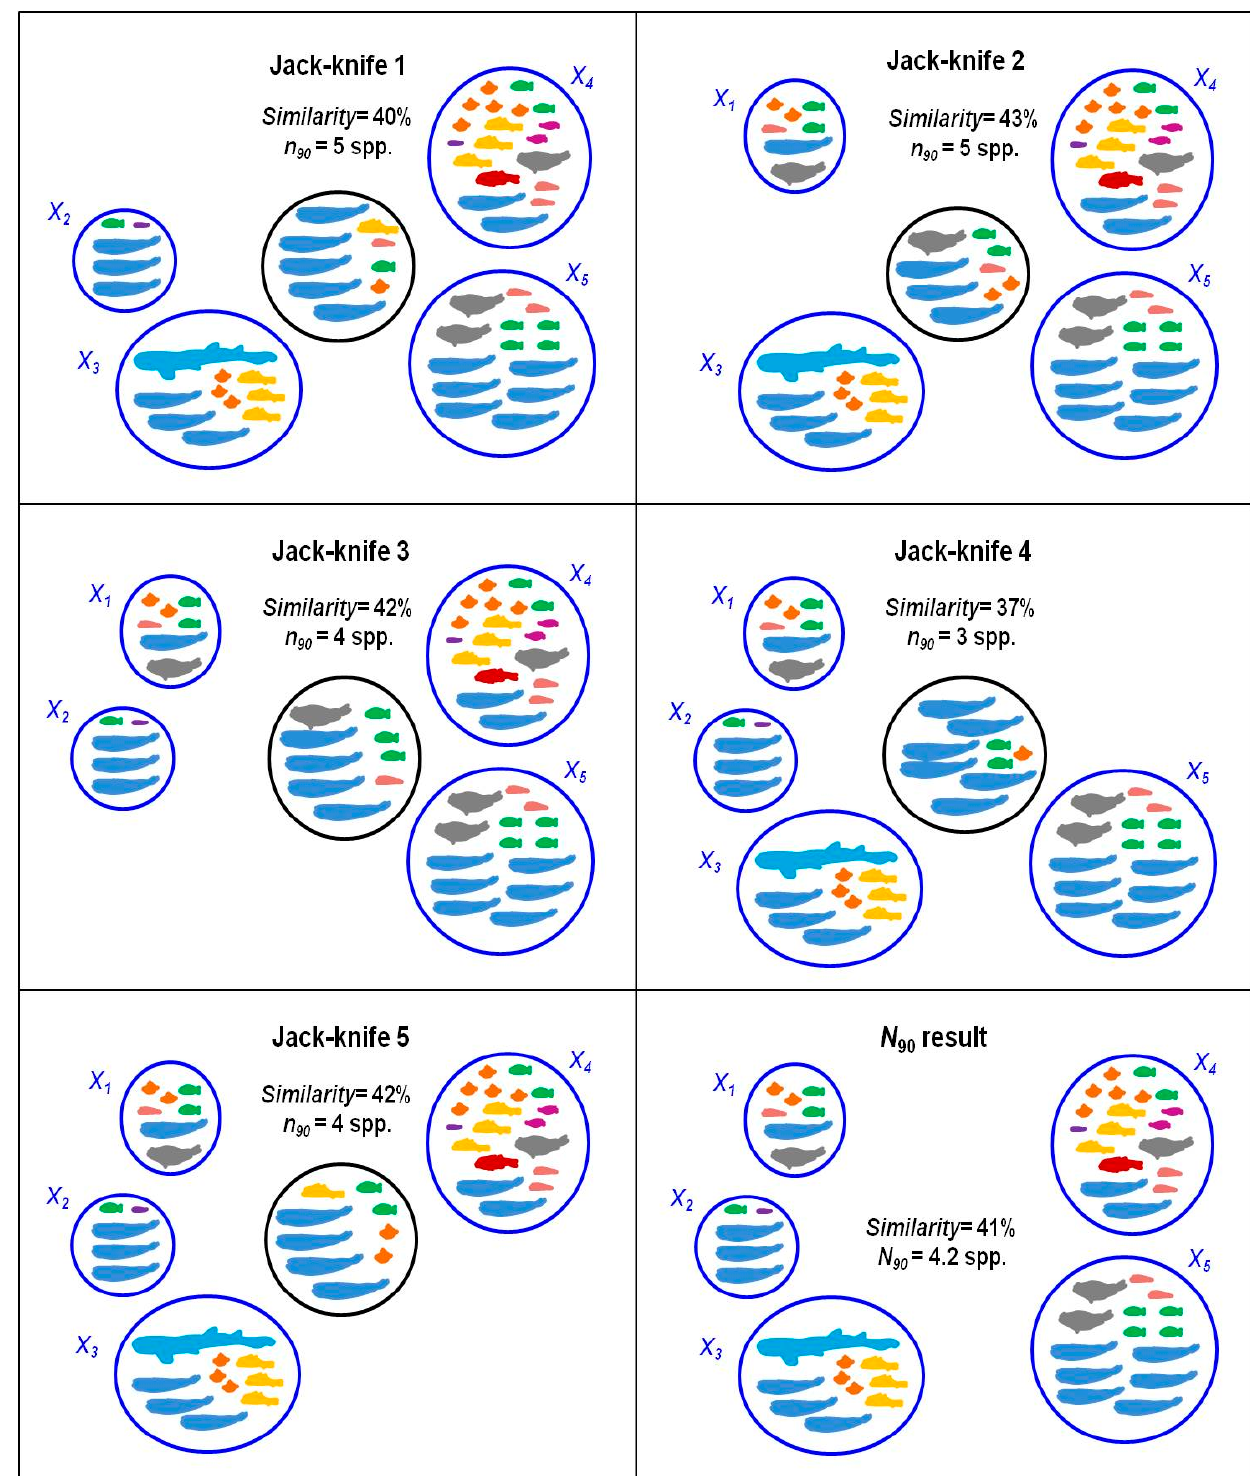
Figure 2. Jack-knifes for the calculation of N 90 in a group with 5 samples. In each Jack-knife a single sample is removed from the group and the number of samples contributing up to 90% to within-group similarity ( n 90 ) and the total similarity of the group is calculated. N 90 is the mean value of n 90 obtained from all the re-samplings.